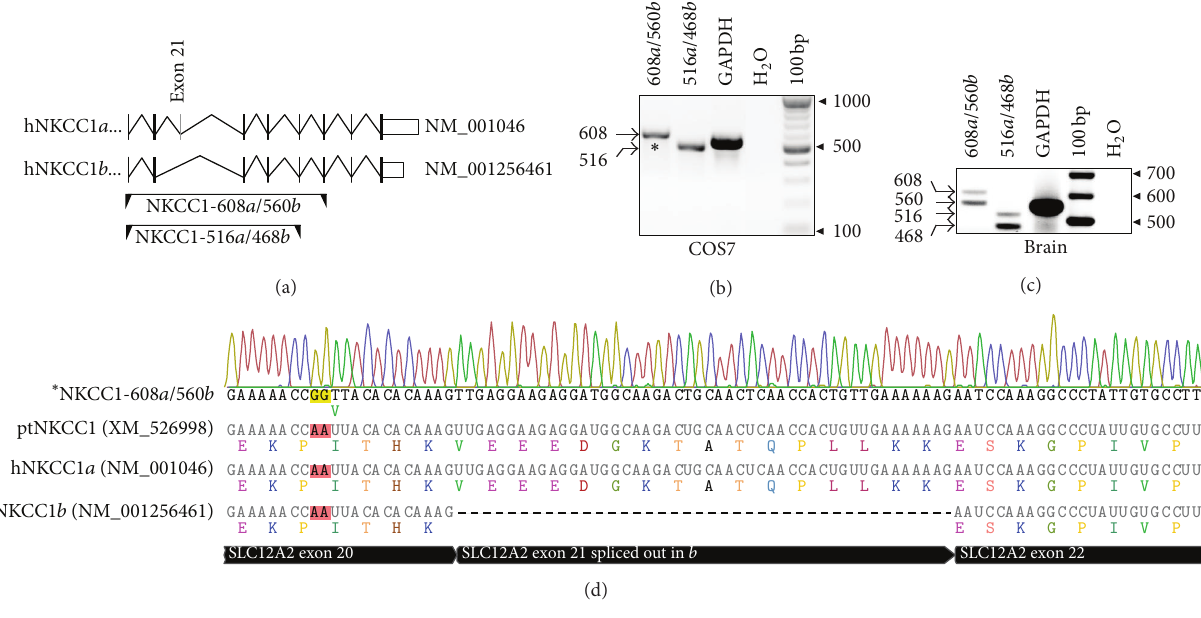
Figure 1: NKCC1 a transcripts are expressed in COS7 cells. (a) Representation of the last nine exons (boxes) of the human SLC12A2 gene. Alternative spliced exon 21 is indicated as a grey box in NKCC1 a (NM 001046). Introns are represented with V-shaped lines. White boxes represent 3 󸀠 -UTRs. Underneath, shown are the primer sets used to coamplify NKCC1 a and NKCC1 b mRNAs (represented as opposite arrowheads connected by a line). These primers are labeled according to the size in bp of the expected amplicons ( see text ). (b) Shown is a representative 2% agarose gel where bands of predicted sizes for NKCC1 a are detected (608bp and 516 bp). (c) In human brain, bands of predicted sizes for NKCC1 a and NKCC1 b are coamplified: 608 bp + 560 bp and 516 bp + 468 bp, respectively. As positive control, RT- PCR reactions amplified GAPDH (555 bp). As negative control, RT-PCR reactions were performed using H 2 O instead of total RNA and GAPDH-555 primer sets. (d) Representative DNA sequence chromatogram corresponding to amplicons obtained with primer set NKCC1- 608 a /560 b encompassing exons 20, 21, and 22 in NKCC1 mRNAs. The sequences obtained from COS7 cells were aligned against chimpanzee (XM 526998) and human NKCC1 transcripts of reference. The sequence difference found in that region is